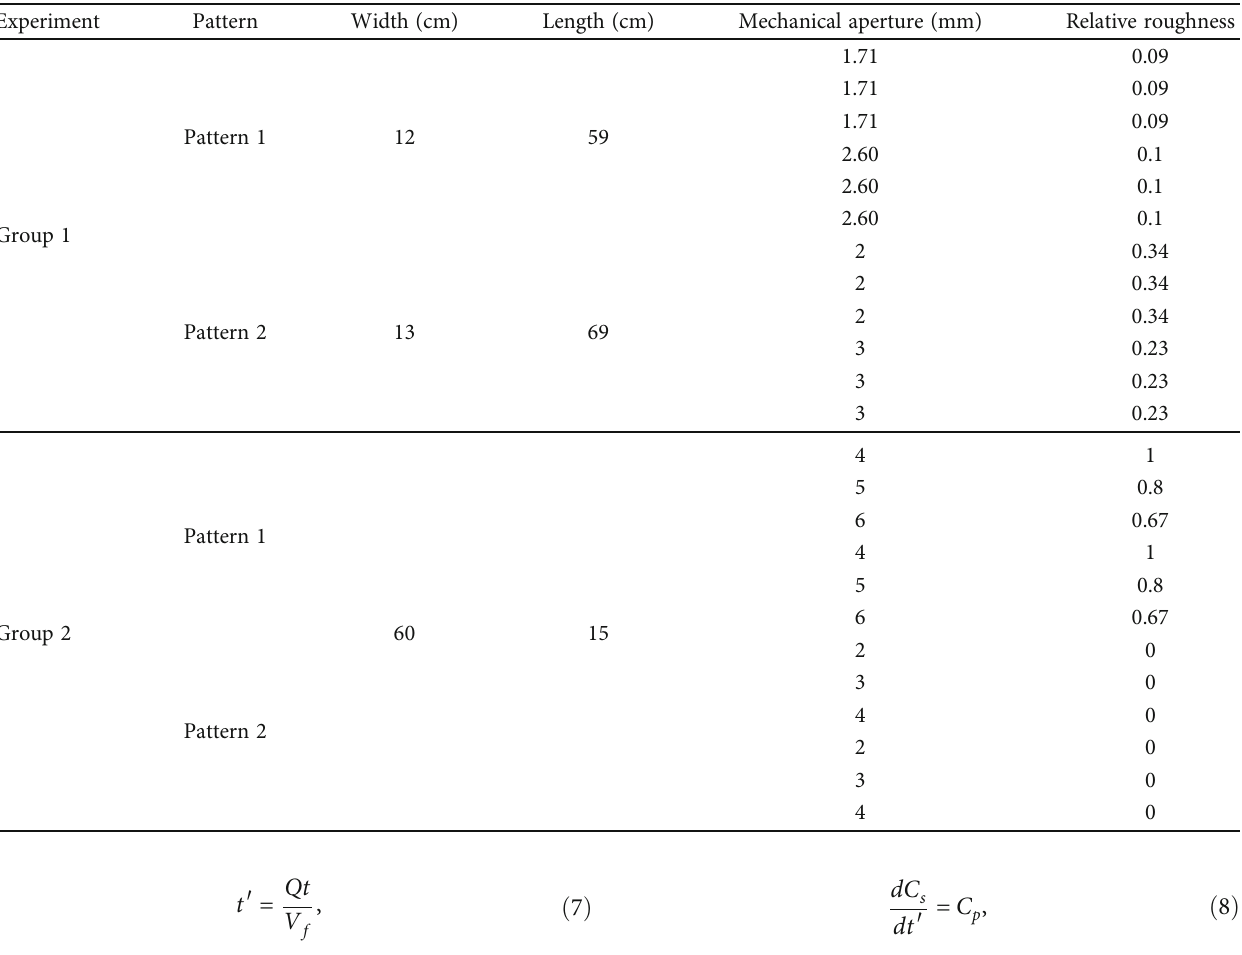
Figure 2: Experimental setup for the BBF transport in a single plexiglass fracture. Table 1: Summary of experimental